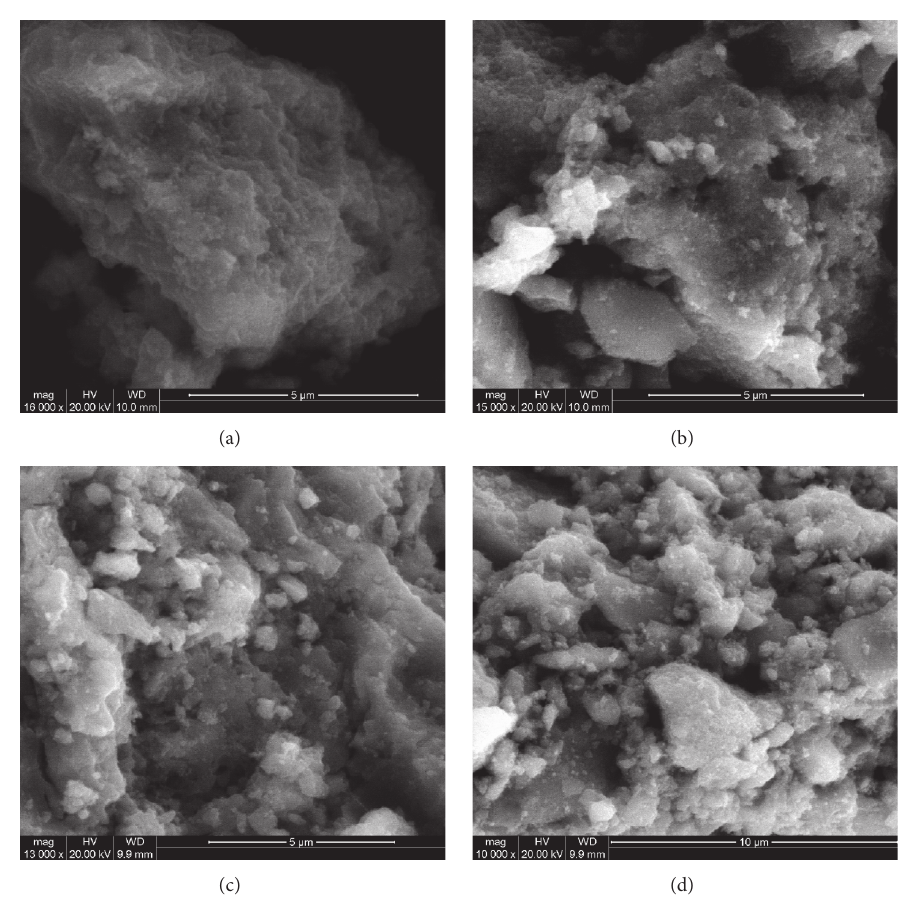
Figure 6: ESEM images for S1–S4 compounds. Table 1: TGA data for S1–S4